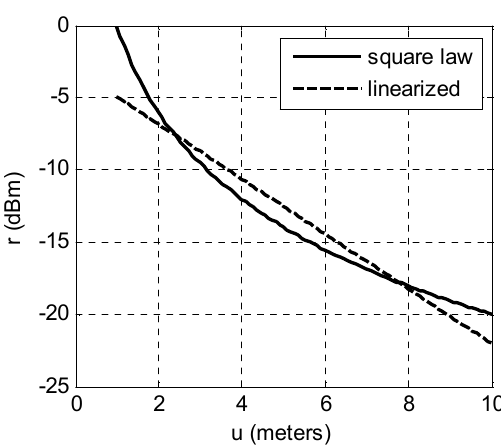
Figure 1. Receiver signal strength (RSS) model error due to linearization.